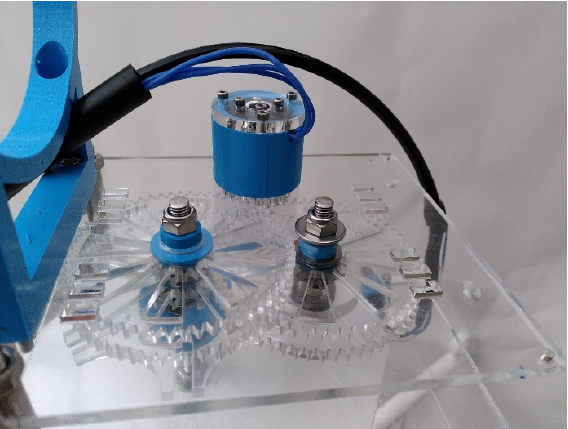
Figure 6. The reducer based on four cogwheels, a drive wheel ( bottom left ), and a Maltese cross ( bottom right ).